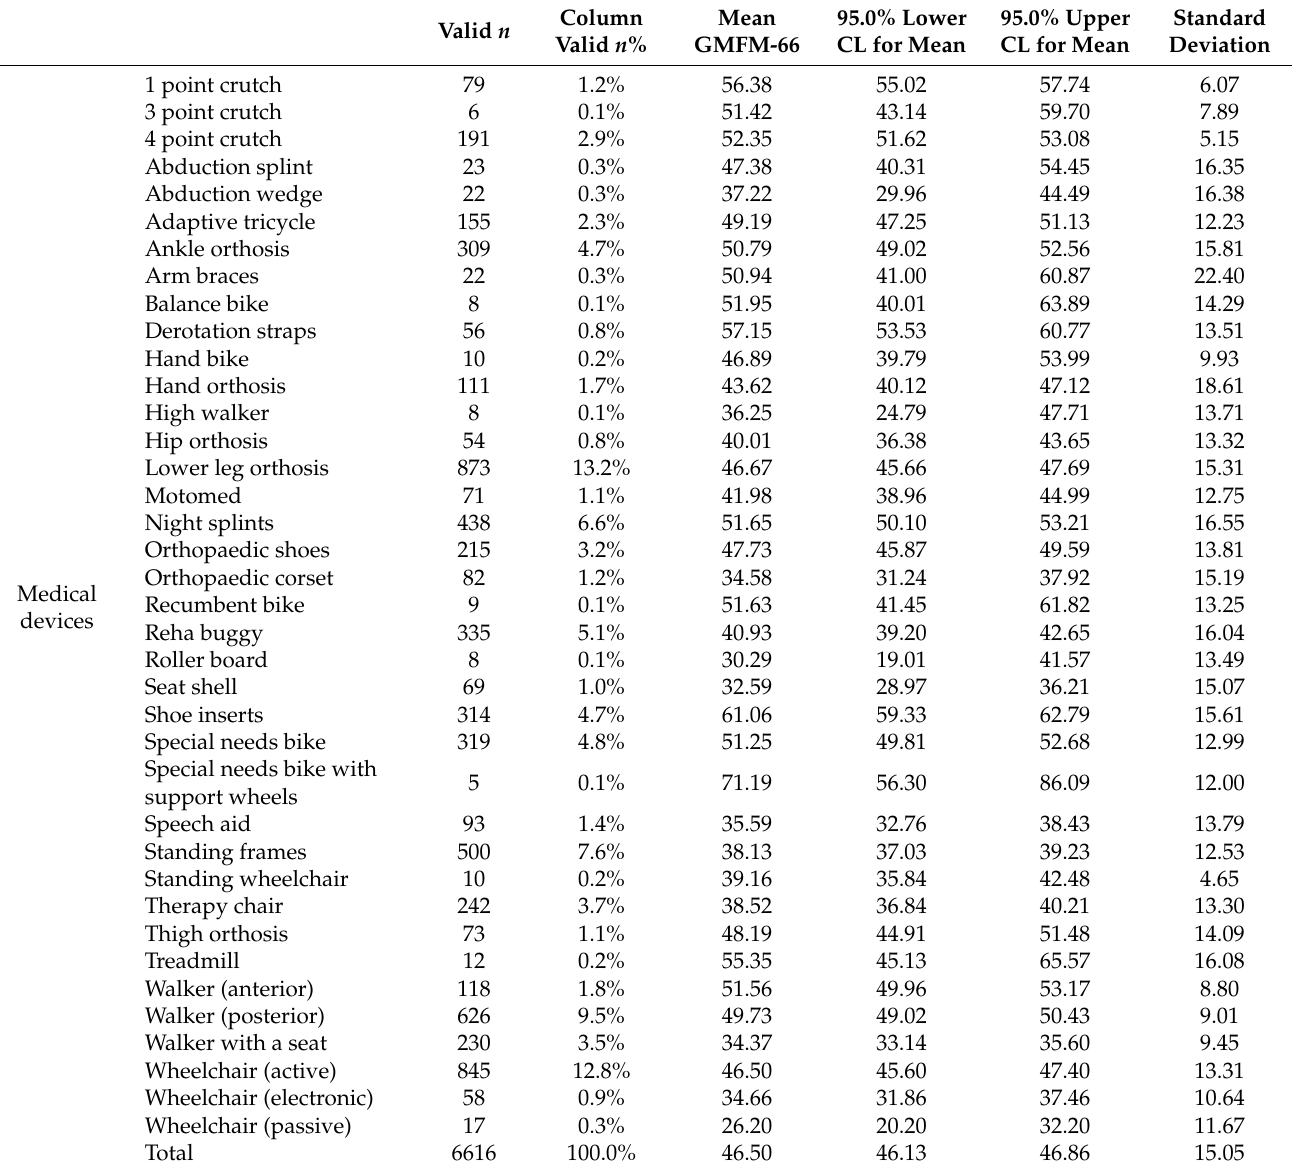
Table A1. GMFM-66 scores and distribution of different medical